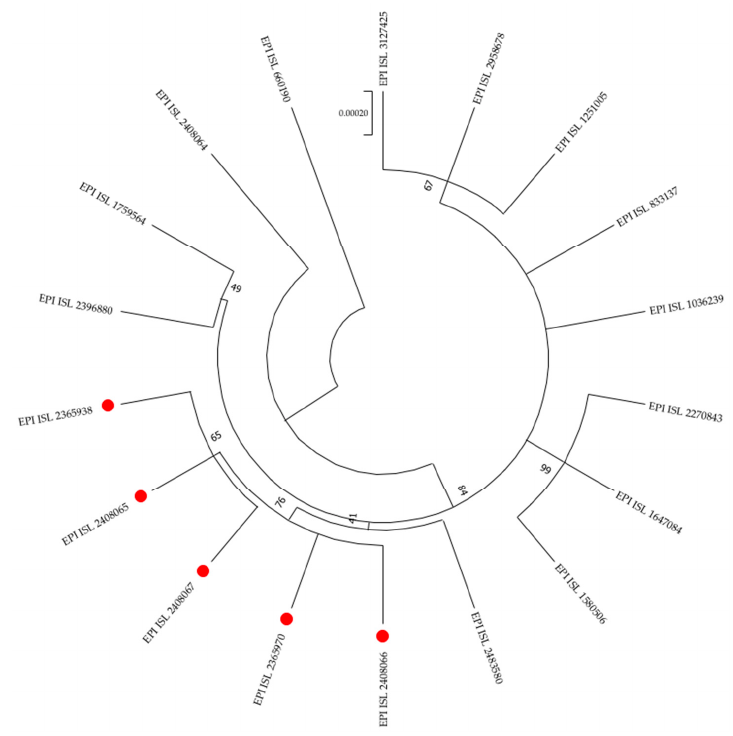
Figure 1. Phylogenetic tree of 18 SARS-CoV-2 full genome sequences, including the five genomes examined in this study (red dots). The reference SARS-CoV-2 genome (GISAID accession number: